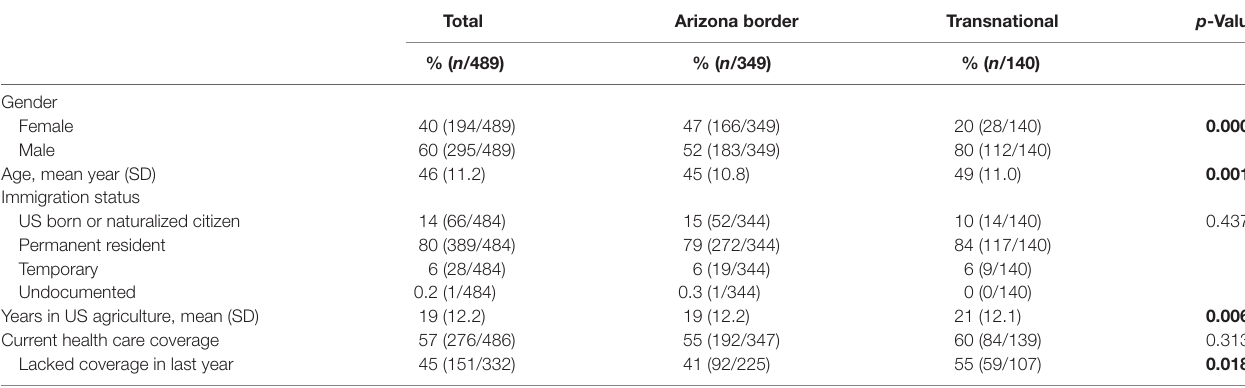
TaBle 1 | Demographic characteristics of arizona-border and transnational